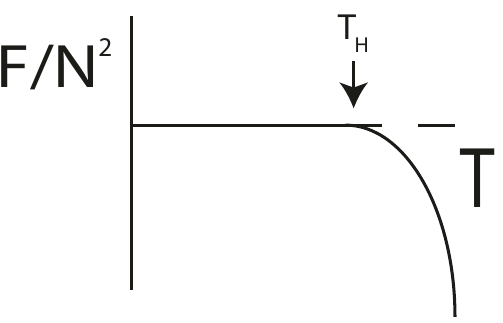
Figure 2 . Free energy versus temperature in the canonical ensemble. The Hagdorn temperature is indicated. For low T the free energy per unit degree of freedom vanishes F=N 2 ! 0 as N ! 1